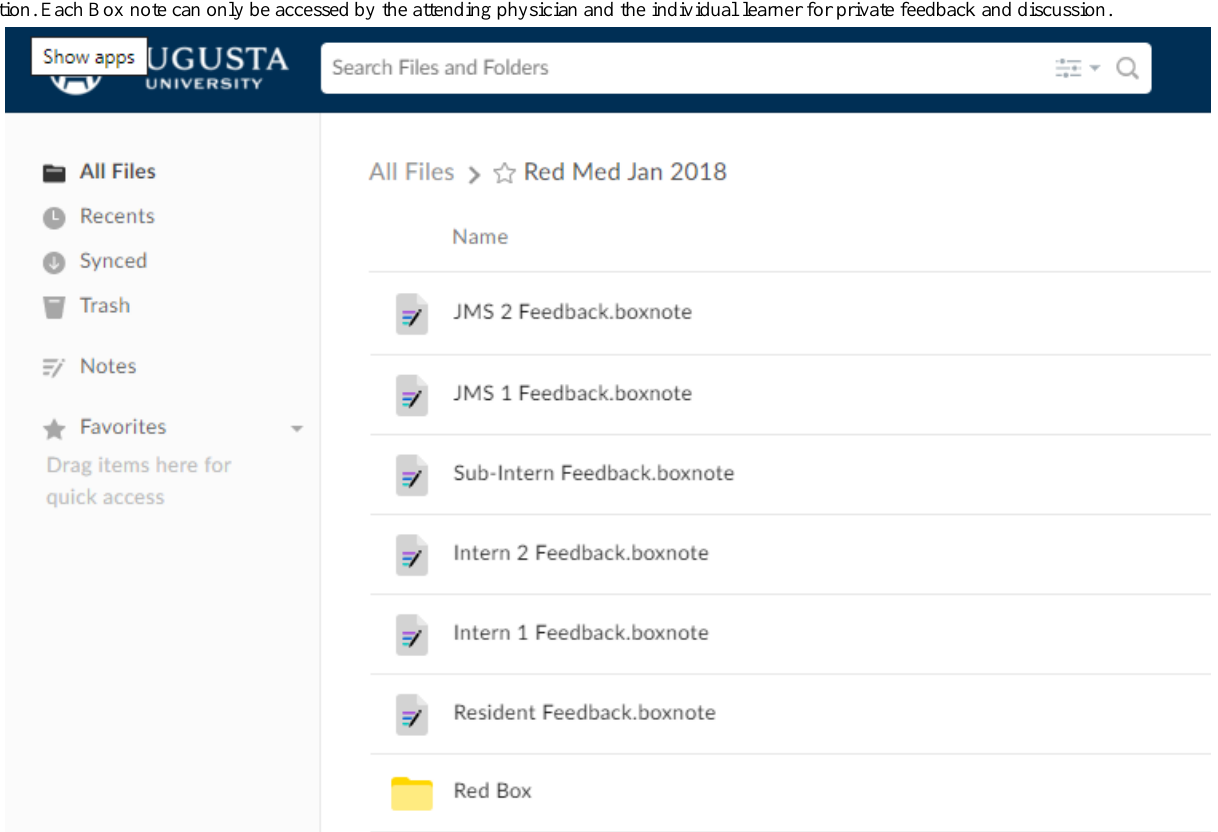
Figure 1. Screenshot of a Box folder from the first day of rotation. This screenshot displays the content that can be found in the "Red Med Jan 2018"